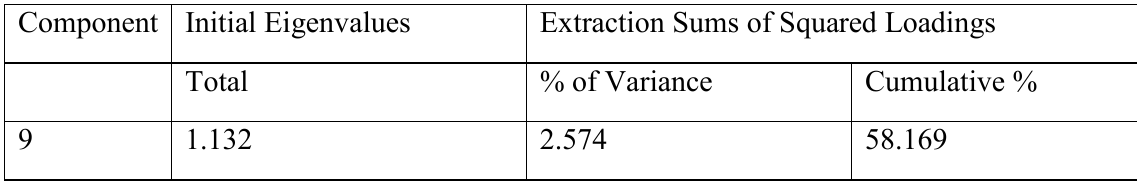
Table 1.17: Variance explained for Absorptive Resilience PC9